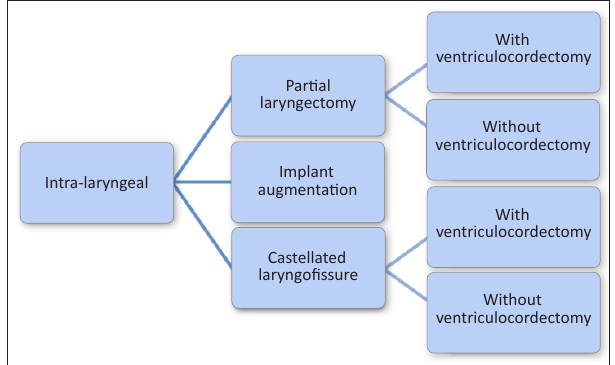
FIGURE 2: Schematic diagram indicating the different intra-laryngeal surgical procedures in dogs with laryngeal paralysis.